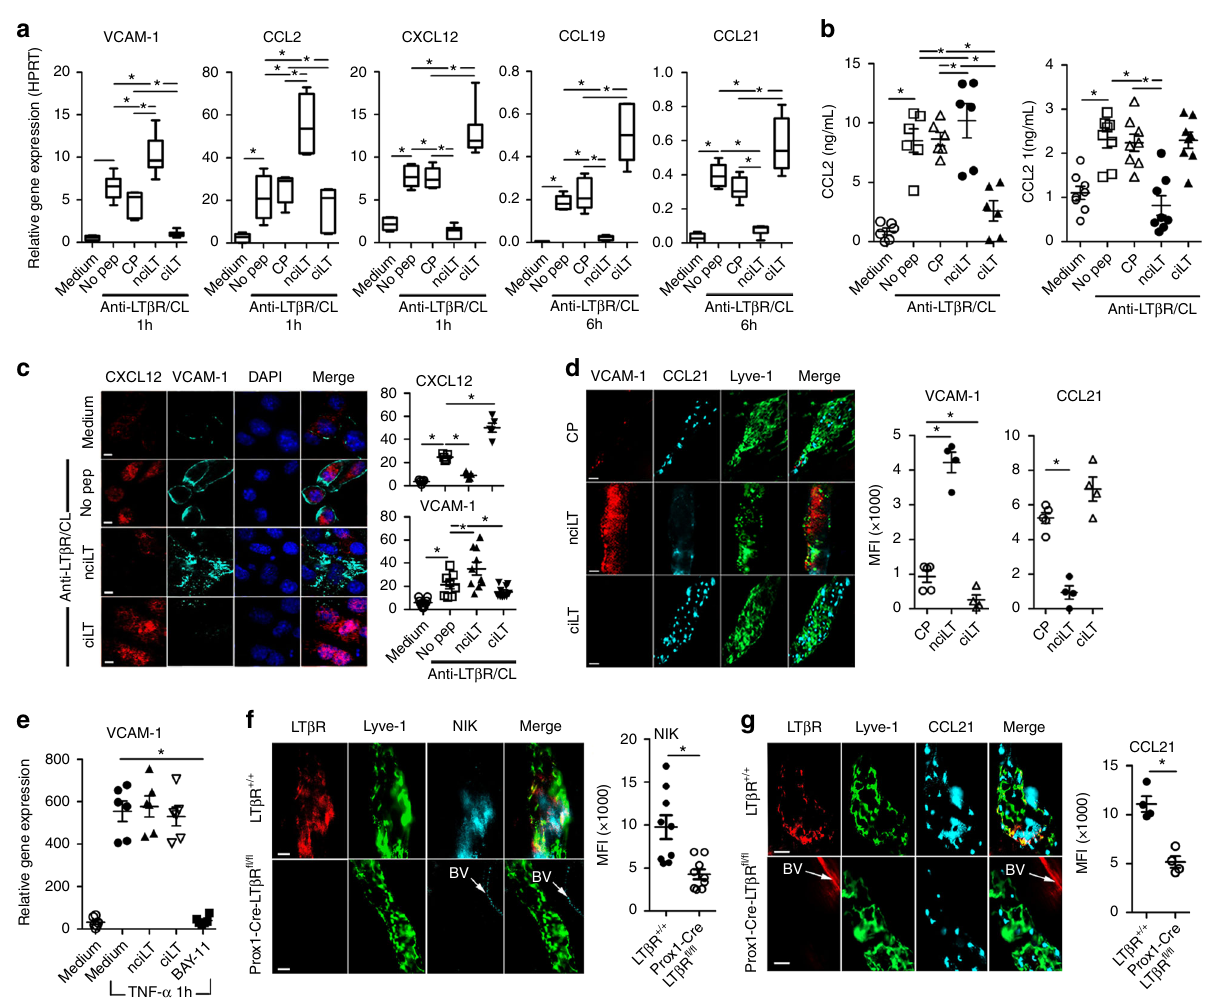
Fig. 4 Regulation of gene pro fi les by the LT β R NF κ B-blocking peptides. a qRT-PCR of VCAM-1 and chemokines in LEC stimulated with anti-LT β R mAb (2 μ g/mL) plus CL with mouse anti-rat IgG1 (2 μ g/mL) for the indicated times. b ELISA for CCL2 and CCL21 in the LEC supernatants after 4 or 16 h stimulation as in a , respectively. c CXCL12 and VCAM-1 expression in LEC after 3 h stimulation as in a . Magni fi cation ×40; scale bar 20 μ m. d C57BL/6 mice injected with 5nmol/ear control peptide (CP), nciLT or ciLT; after 3 h ears were fi xed for whole-mount ear staining. Magni fi cation ×20; scale bar 50 μ m. e qRT-PCR of VCAM-1 in LEC stimulated with TNF α (20 ng/mL) for 1h. f , g Whole-mount ear staining of NIK and CCL21 in Prox1-Cre-ER T2 + / − LT β R fl / fl mice 10 days after tamoxifen treatment (0.125mg/g i.p. for 5 consecutive days). BV blood vessel. Magni fi cation ×60; scale bar 10 μ m. * p < 0.05 by one-way ANOVA ( a – e ) or by Student ’ s t- test ( f , g Immunohistochemistry showed co-expression of LT β R and classical pathway CCL2 and VCAM-1 expression and inhibited NIK on LEC and SVEC4-10, with co-localization of the two homeostatic CXCL12, CCL19, and CCL21 chemokine production molecules in confocal images (Figs. 1b, 3f). nciLT and NIKi via the non-classical pathway, as measured by RT-PCR (Fig. 4a), inhibited NIK expression and its co-localization with LT β R, ELISA (Fig. 4b), and immunohistochemistry (Fig. 4c). nciLT was without affecting LT β R expression (Fig. 3f). In contrast, neither also effective in vivo and signi fi cantly decreased the expression of ciLT nor BAY11-7085 affected NIK expression or co-localization CCL21 and increased VCAM-1 expression on Lyve-1 + lymphatic vessels (Fig. 4d). Conversely, ciLT blockade of the LT β R-classical with LT β R. In addition, LT β R activation induced RelB nuclear NF κ B pathway suppressed classical pathway induced CCL2 and translocation which was suppressed by nciLT but not ciLT VCAM-1 and enhanced non-classical homeostatic chemokines (Fig. 3g). Together, these data con fi rmed the speci fi city and CXCL12, CCL19, and CCL21 (Fig. 4a – d). Both peptides showed mechanism of activity of nciLT in comparison to the other three LT β R-speci fi c inhibition since TNFR1-mediated VCAM-1 expres- molecules. sion was not affected by either nciLT or ciLT, yet was signi fi cantly inhibited by BAY11-7085 (Fig. 4e). Thus, these peptides speci fi cally Gene pro fi les are regulated by LT β R-NF κ B-blocking peptides . inhibited gene expression regulated by the classical and non- To further validate the peptide inhibitor speci fi cities and mechan- classical pathways engaged by LT β R. Selective deletion of LT β R in isms, their actions were related to the separate LT β R signaling Prox1-expressing lymphatics 10 days after tamoxifen treatment of pathways and speci fi c gene activation. The blocking peptides were Prox1-Cre-ER T2 + / − LT β R fl / fl mice also diminished NIK and CCL21 assessed for their effects on early classical pathway and later non- expression (Fig. 4f, g), con fi rming the importance of LT β R and NIK classical pathway gene activation and expression in LEC. nciLT, signaling. which blocked LT β R-non-classical NF κ B signaling, enhanced early